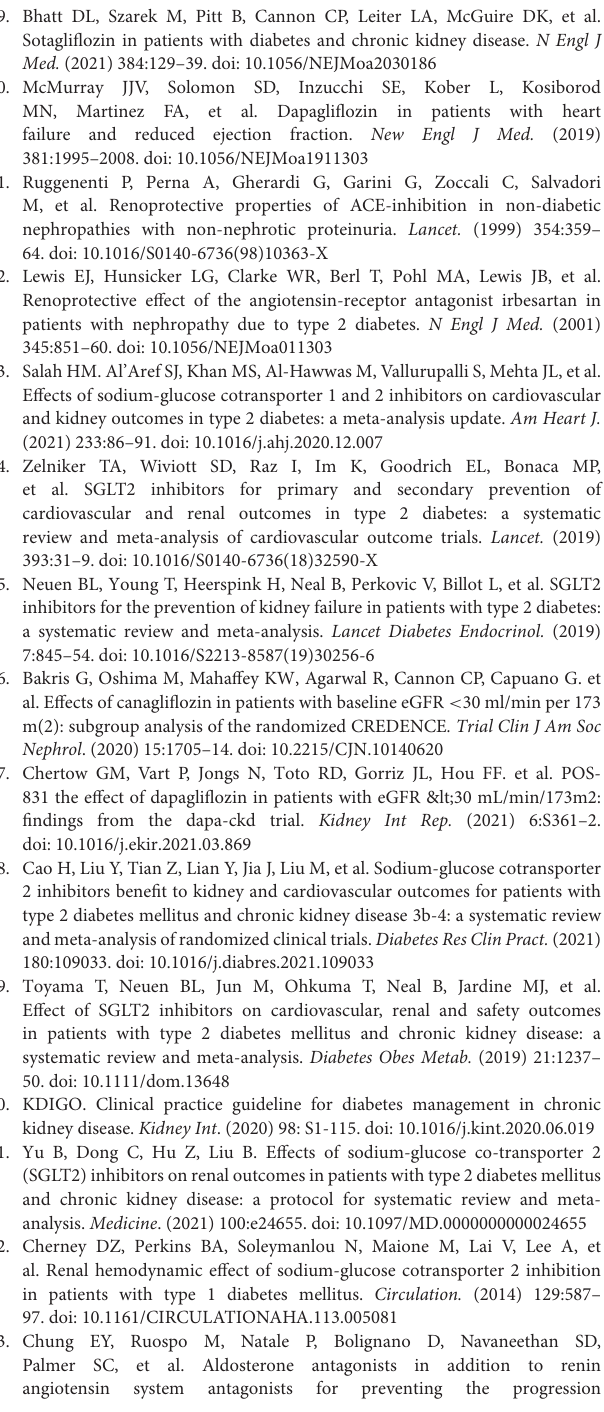
Supplementary Table 1 | Kidney outcome ascertainment and adjudication across included studies. Supplementary Table 2 | Definitions for ESKD-based kidney outcomes. Supplementary Table 3 | Difference of slope-based outcomes.